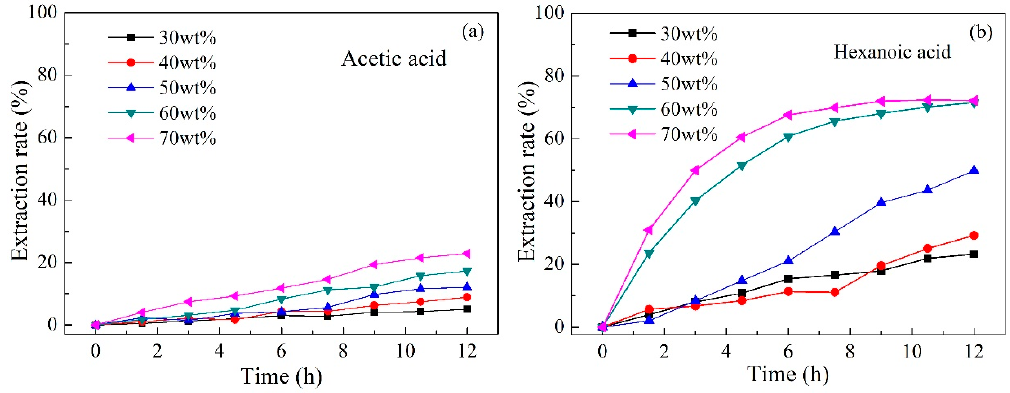
Figure 4. Effect of the Aliquat 336 content on the separation of ( a ) acetic acid and ( b ) hexanoic acid by PIMs (PIMs: PIM1, PIM2, PIM3, PIM4, and PIM5; Feed solution: 0.01 mol L − 1 acetic acid + 0.01 mol L − 1 hexanoic acid, pH = 6; Stripping solution: 0.1 mol L − 1 HCl).